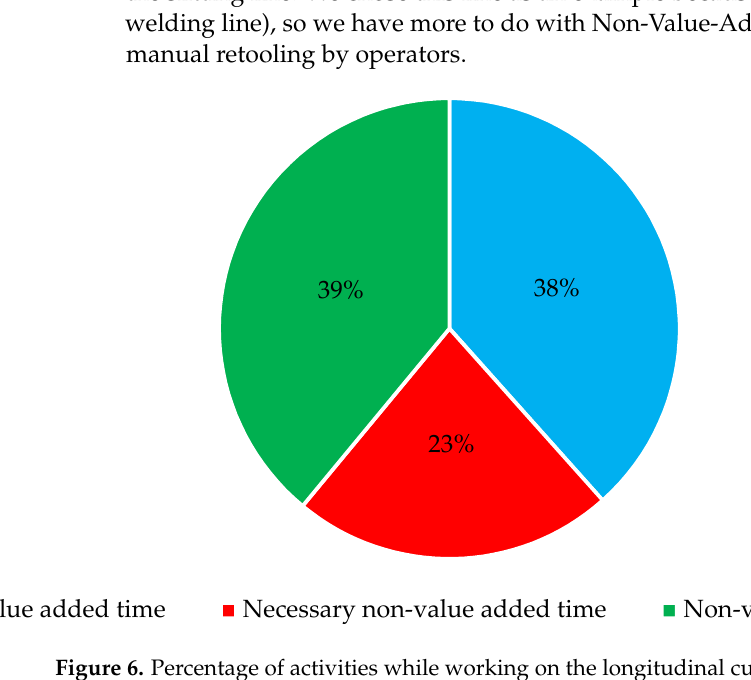
Figure 6. Percentage of activities while working on the longitudinal cutting line.